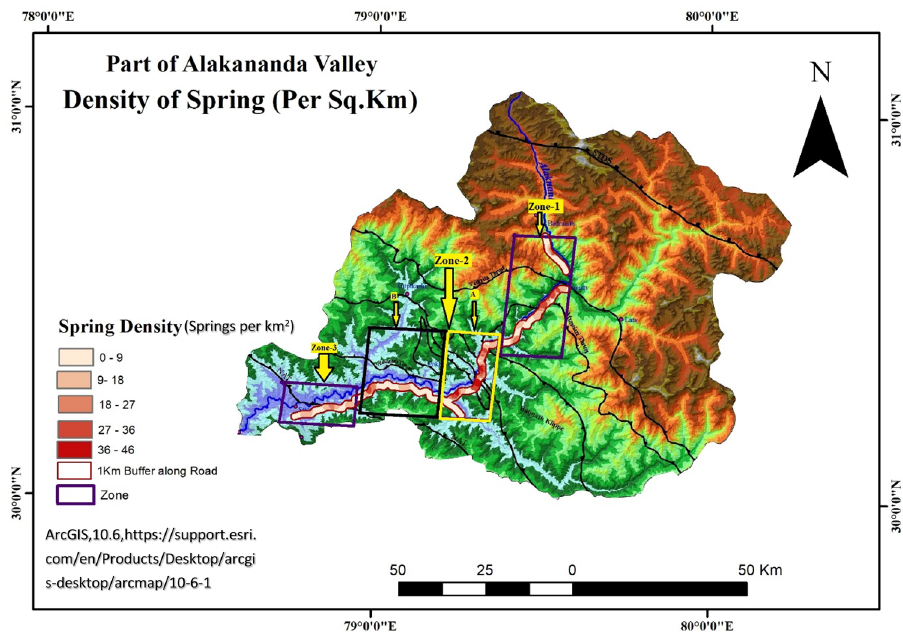
Figure 3. Spring density in per km 2 in Zones-1, 2 and 3 and in compartmentalised Zone-2 (i.e., A and B ), georeferenced and modified after 17 ).